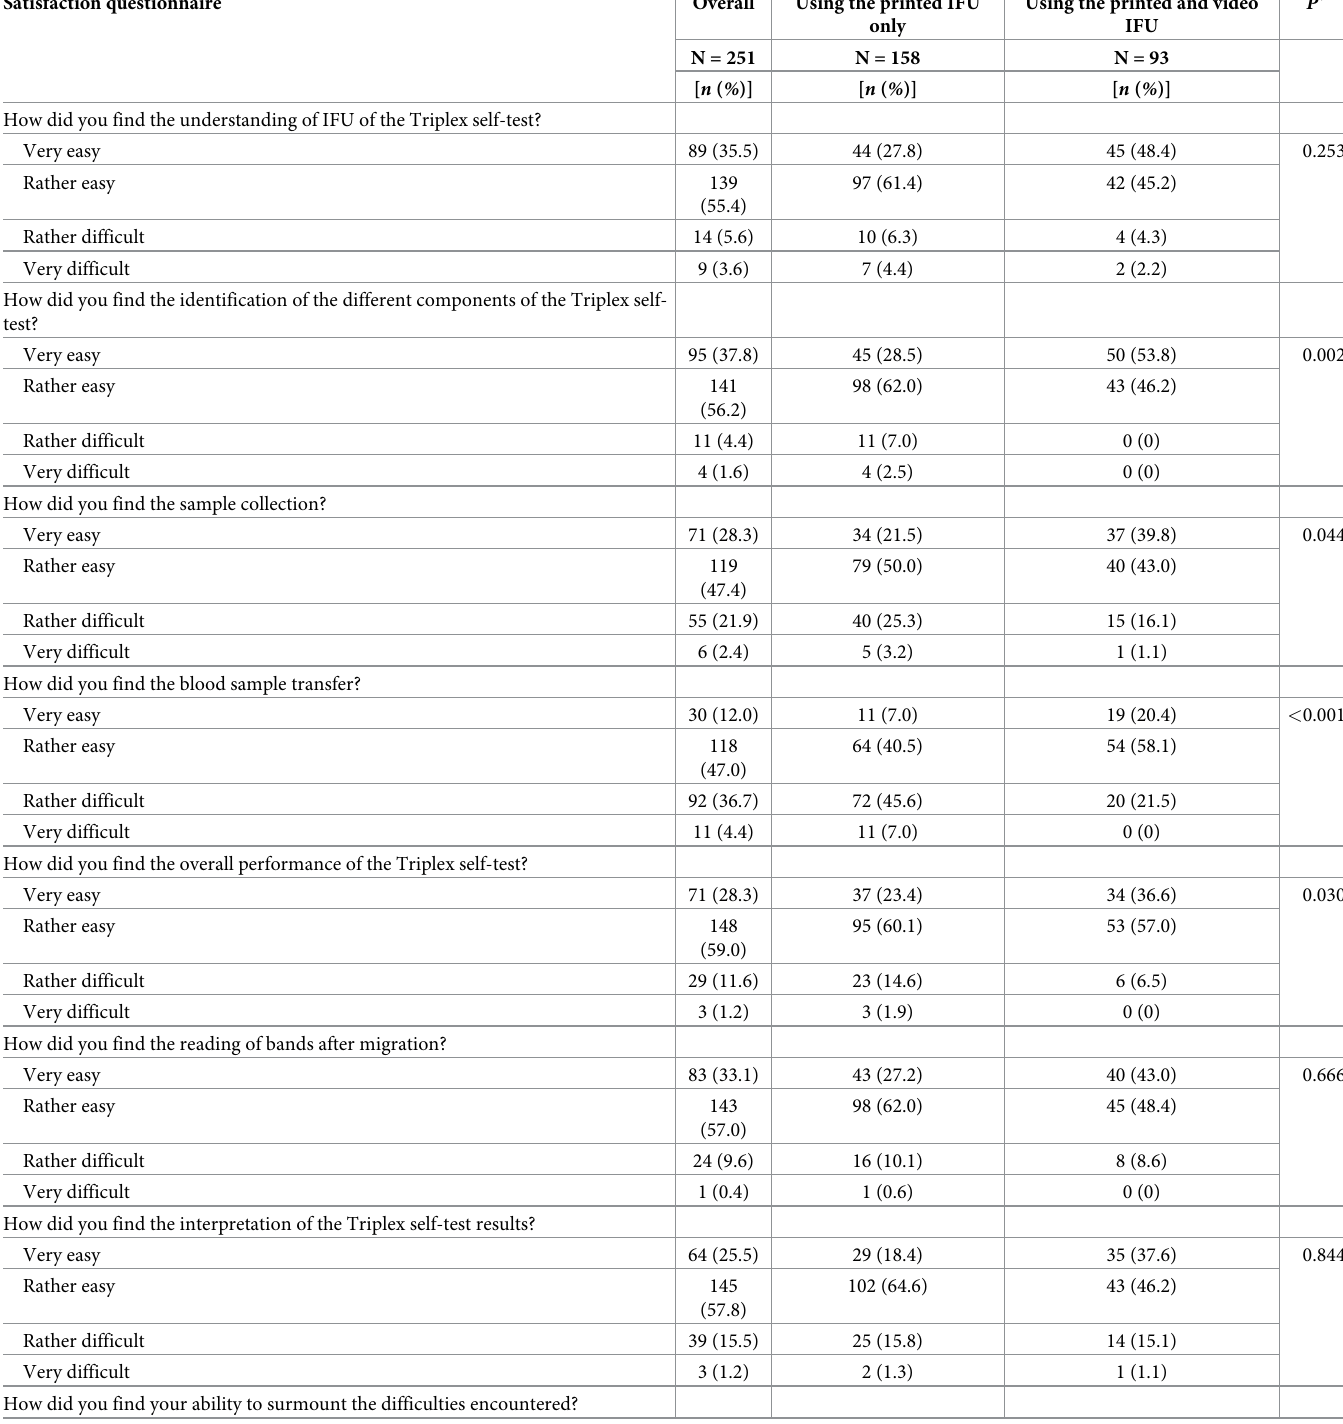
Table 4. Items and analytical results of the satisfaction questionnaire concerning the overall performance of the Triplex HIV/HCV/HBsAg self-test (substudy 1) and interpretation of the Triplex self-test results (substudy 2). Satisfaction